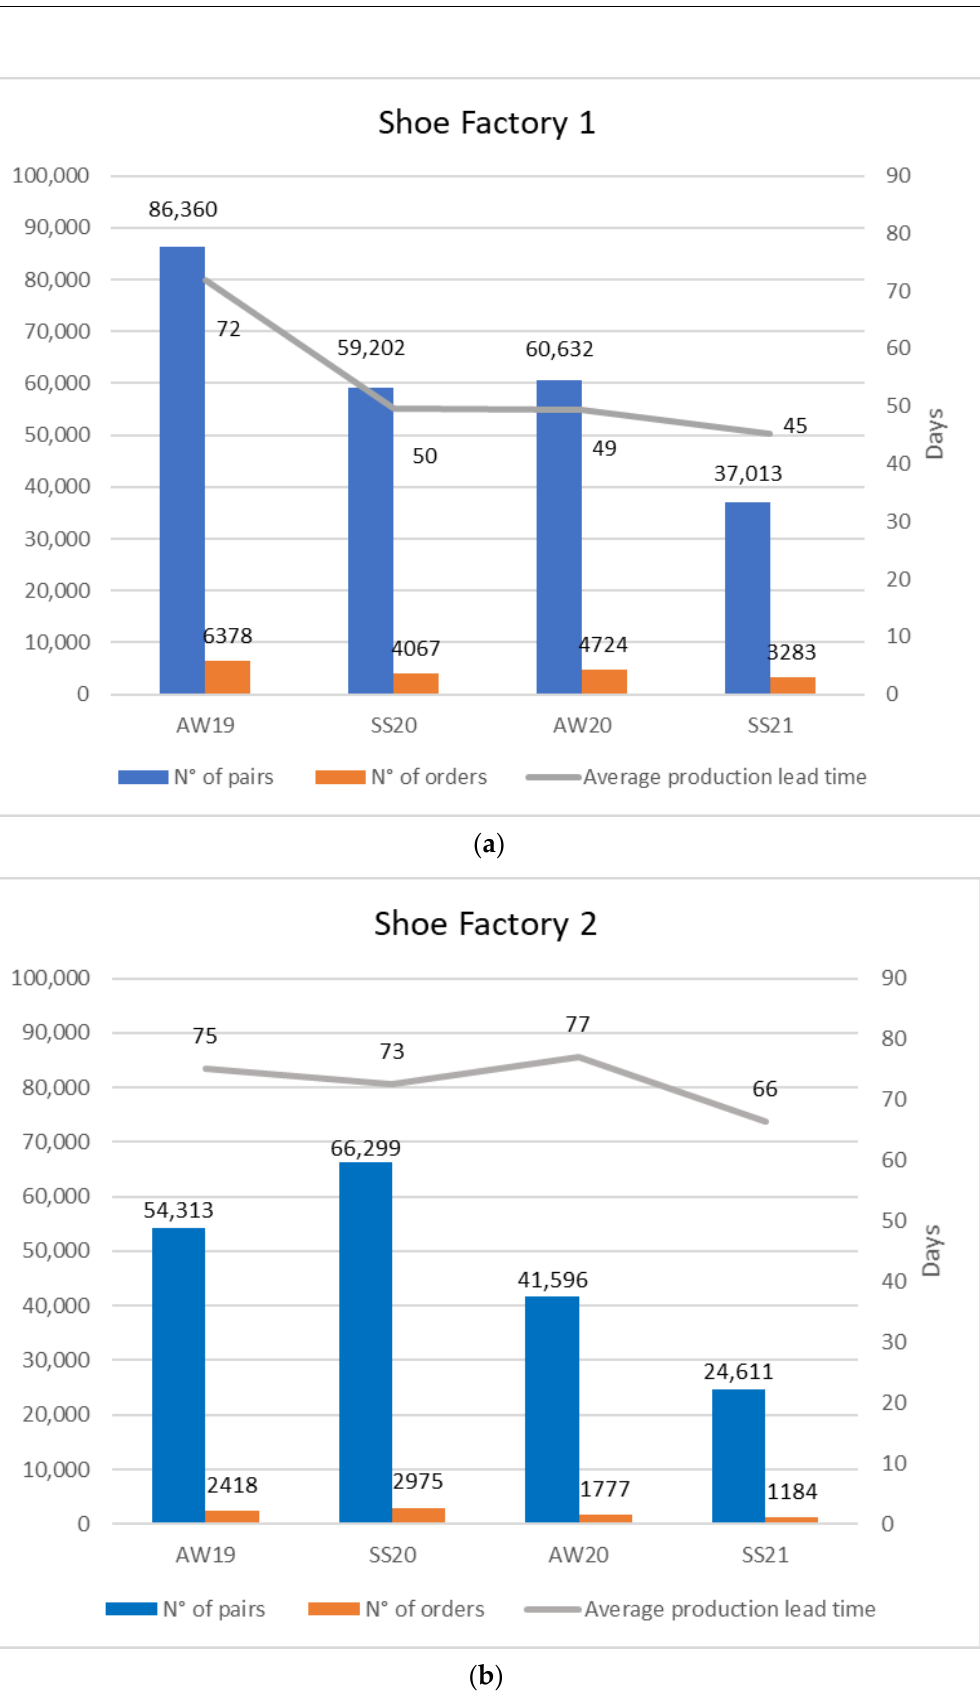
Figure 2. Shoe factories — seasonal N° of pairs, N° of orders, and average production lead time of SF1 ( a ) and SF2 ( b ).